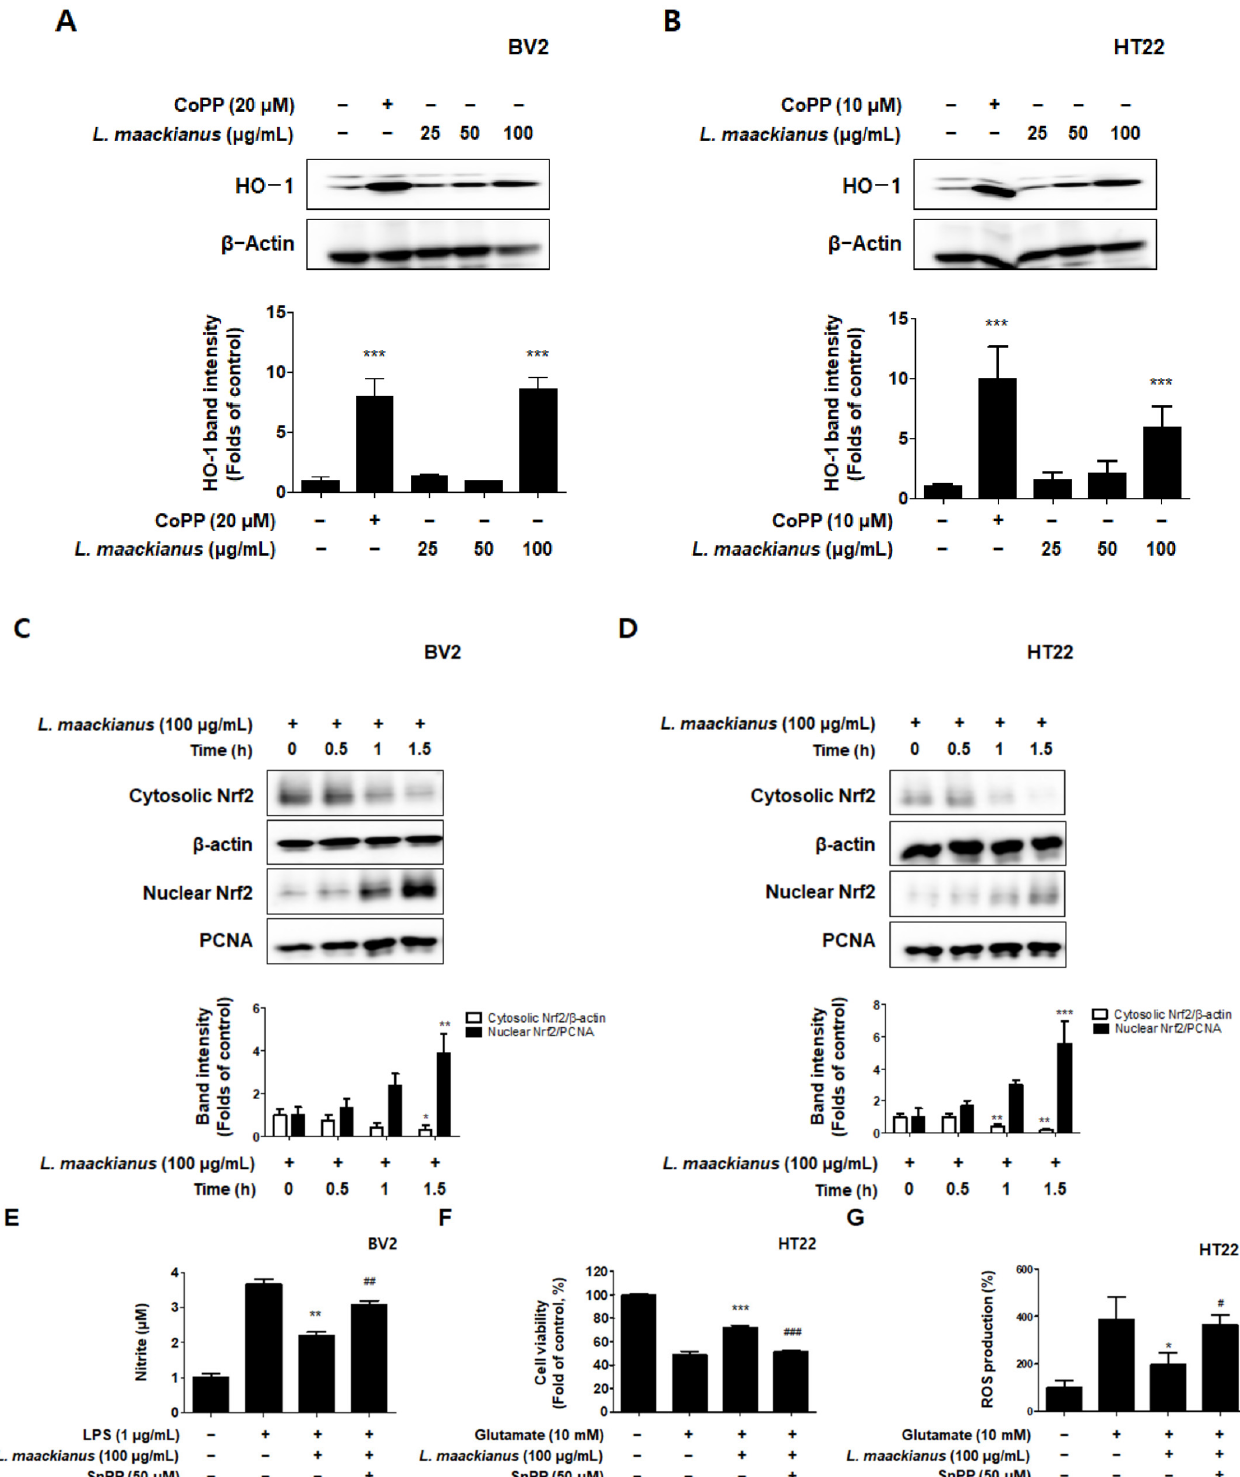
Figure 6. Effect of L. maackianus extract on nuclear factor E2-related factor 2 (Nrf2)/heme oxygenase (HO)-1 protein expression in BV2 and HT22 cells. HO-1 expression levels ( A , B ) were determined